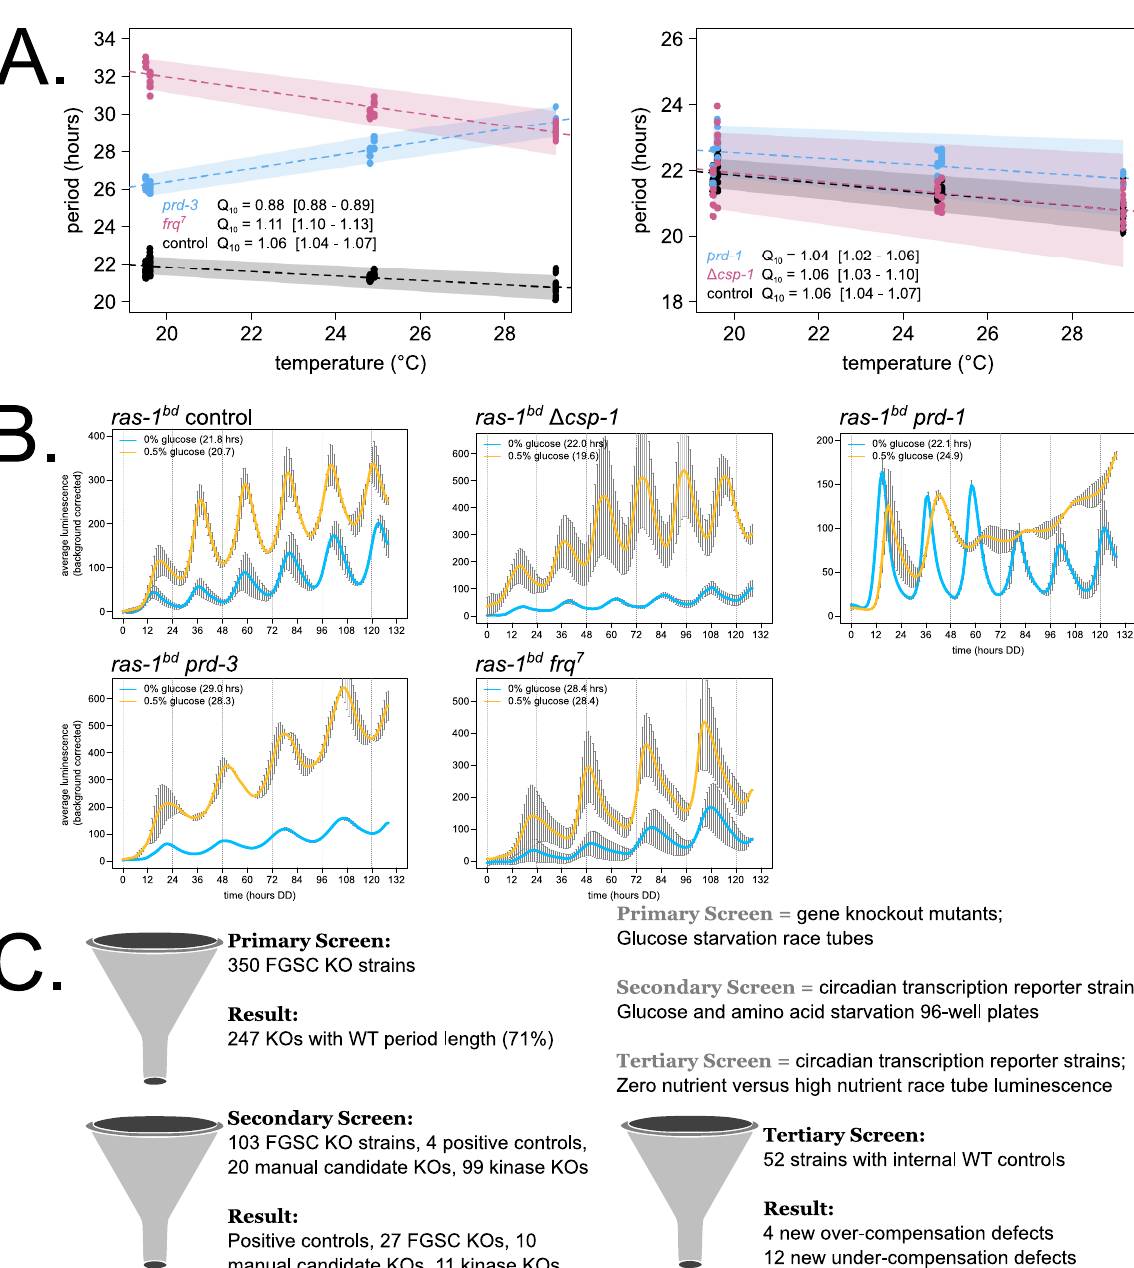
PLOS Biology | https://doi.org/10.1371/journal.pbio.3001961 January5, 2023 5 /